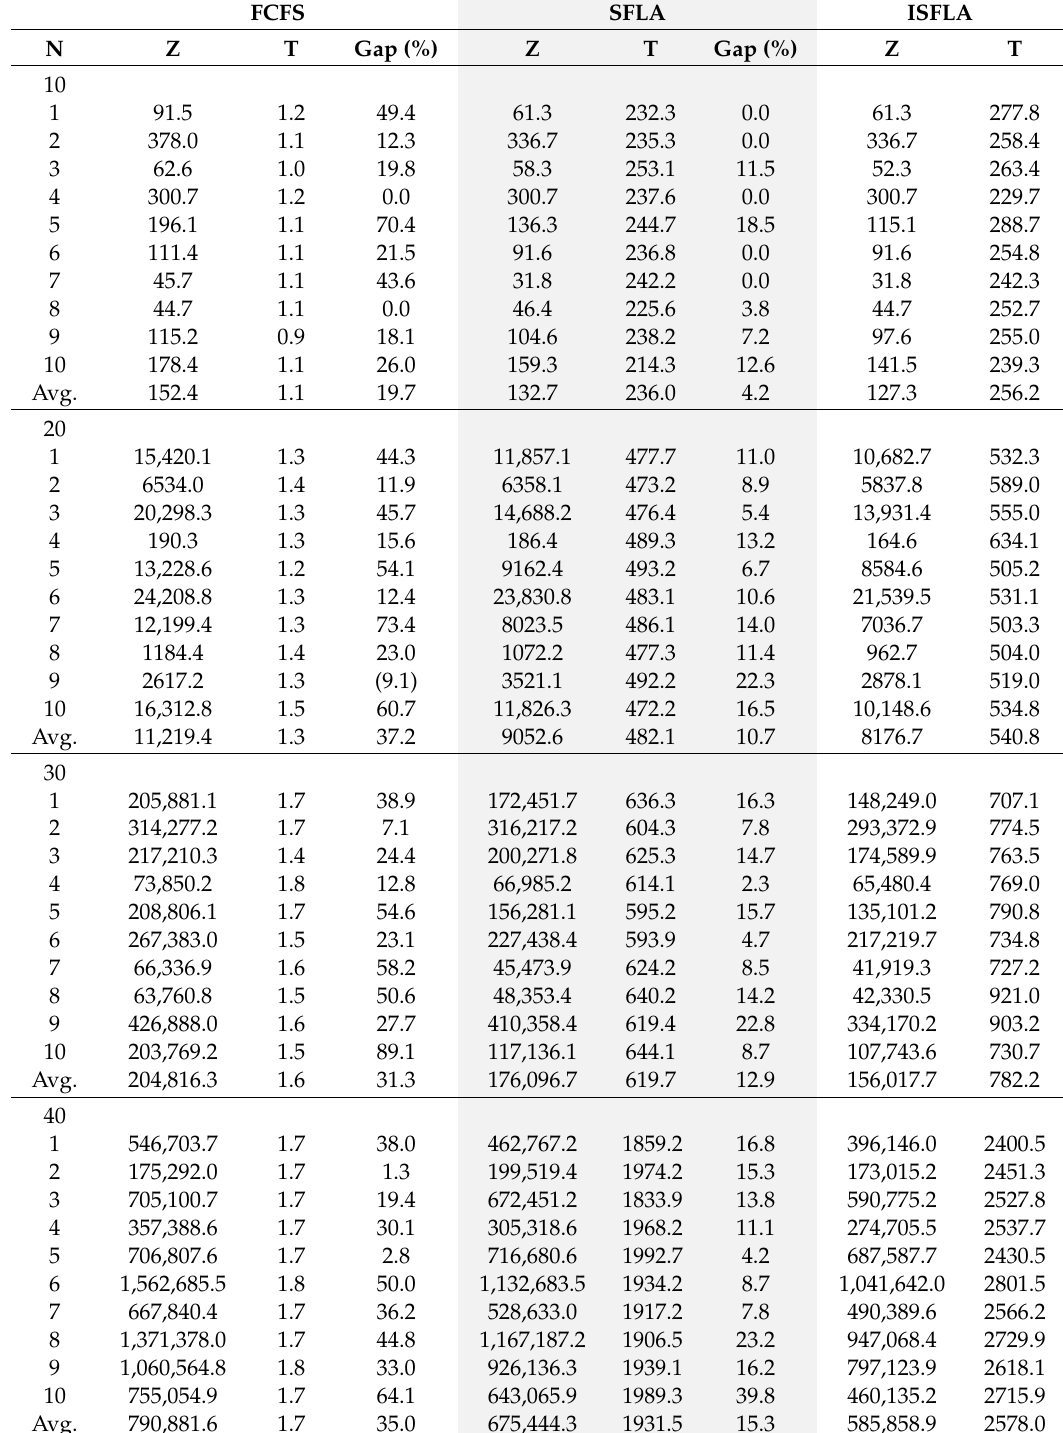
Table 4. The results obtained from di ff erent approaches at di ff erent problem sizes. FCFS